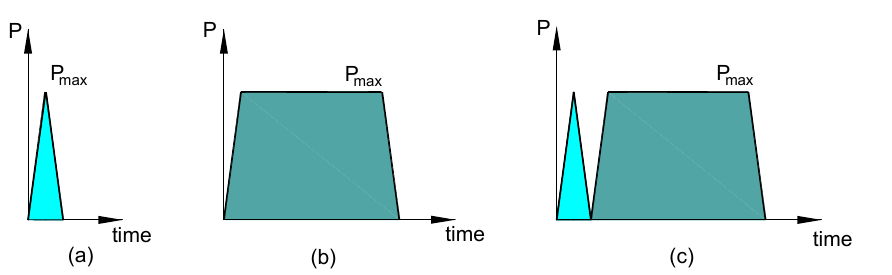
Figure 1. Schematic representation of the indentation loading profile for ( a ) 2-step, ( b ) 3-step, and ( c ) 2-cycle indentation tests.